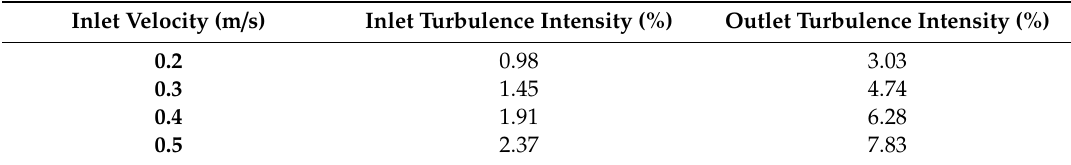
Table 4. CFD-simulated changes in turbulence intensity with different inlet velocities. Inlet Velocity (m/s)